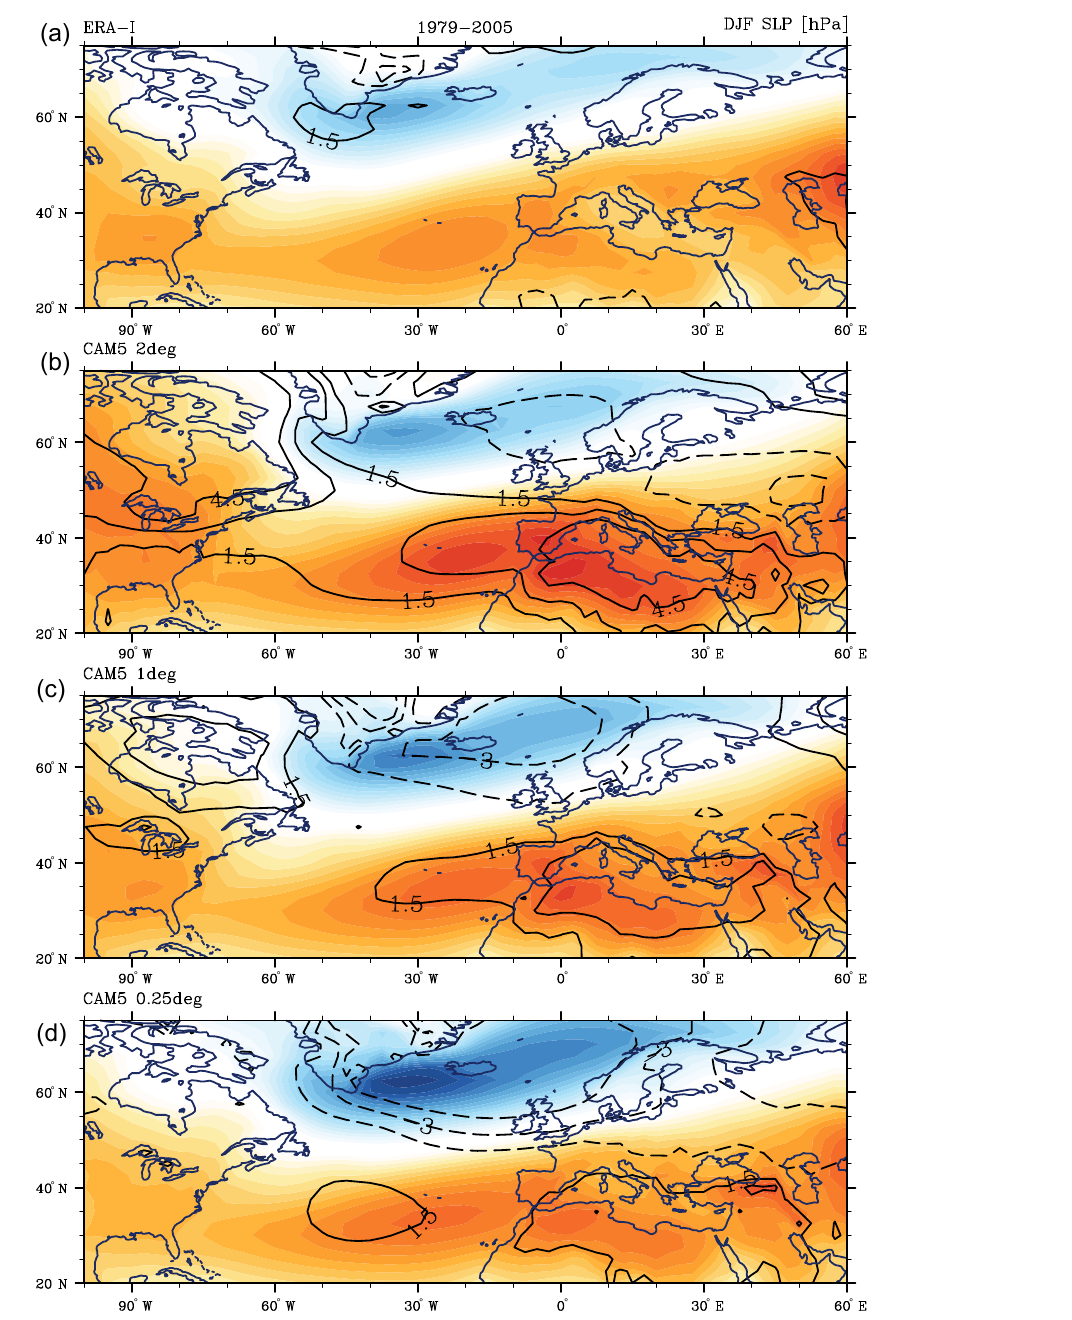
Figure 1. Time-mean average of the DJF sea level pressure (hPa) over the period 1979–2005, regridded to a 2.5 ◦ × 2.5 ◦ horizontal grid for ERA-Interim (ERA-I, ∼ 0.75 ◦ lat–long original resolution), and CAM5 at ∼ 2 ◦ (CAM5_2deg), ∼ 1 ◦ (CAM5_1deg) and ∼ 0.25 ◦ (CAM5_0.25deg) lat–long resolution. Contours show a difference in reference to (a) NCEP-DOE 2 (2.5 ◦ lat–long) and (b–d)